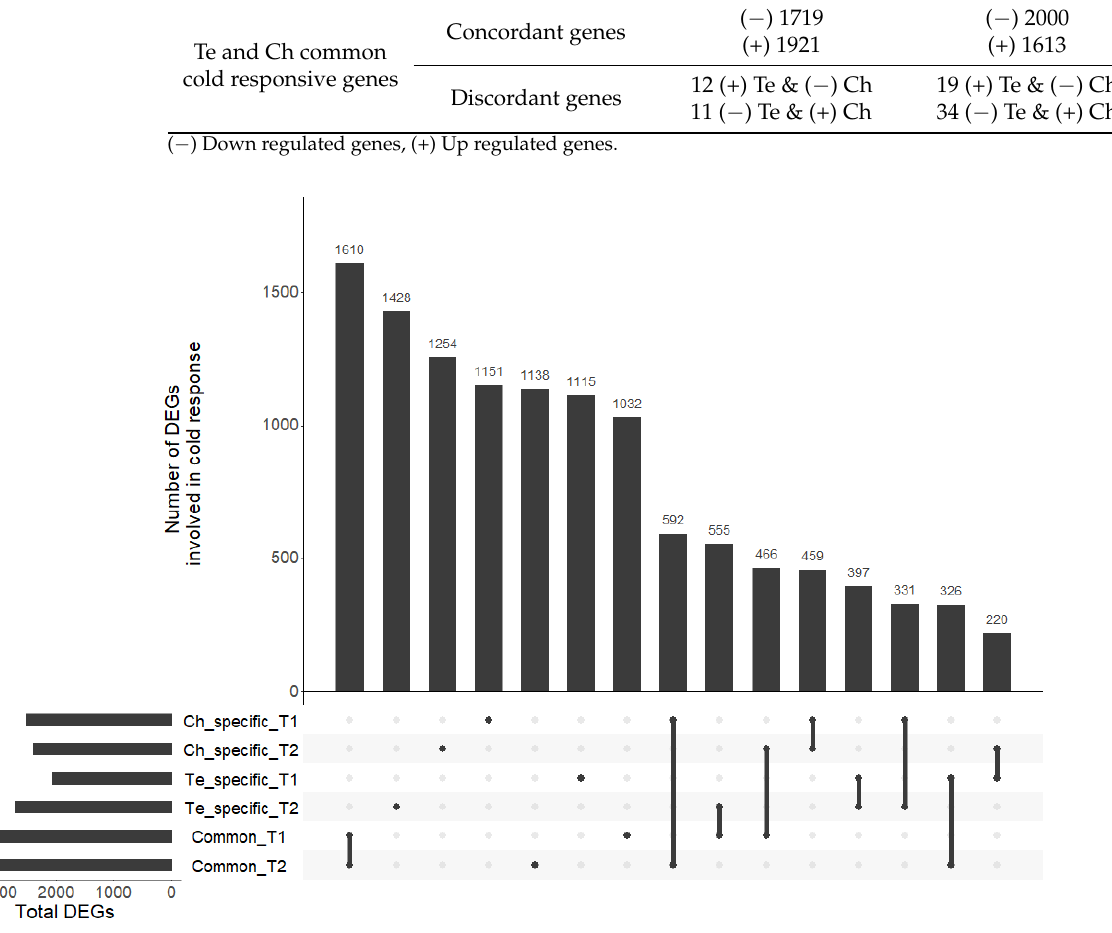
Figure 4. UpSet plot of the six sets of DEGs. All intersections of the six sets are sorted by size. Dark circles in the matrix indicate sets that are part of each